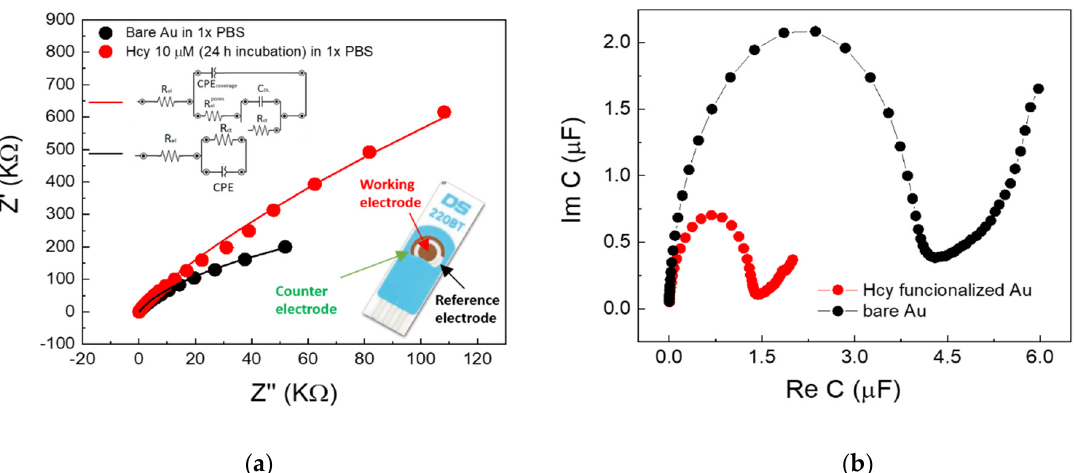
Figure 3. ( a ) Nyquist plot for the gold working electrodes of a SPE before (black symbols) and after (red symbols) their incubation in Hcy:HCl:PBS solutions (HCy concentration of 10 µ M); continuous lines are the related fitting curves for the proposed equivalent circuit analysis; the inset shows a real picture of the commercial SPE used in this experiment. ( b ) Complex capacitance plot of the bare (black symbols) and covered (red symbols) electrodes calculated from the acquired complex impedances.